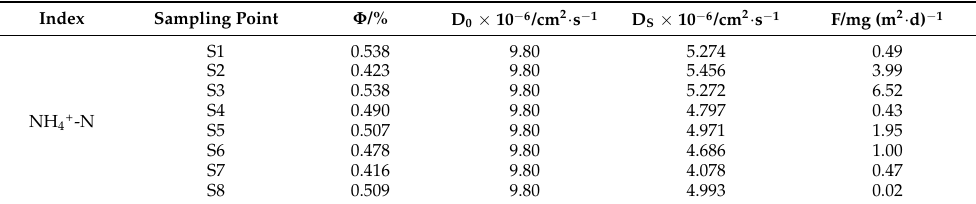
Table 5. Porosity, diffusion coefficient and diffusion flux of NH 4+ -N at the sediment–water interface of the Yitong